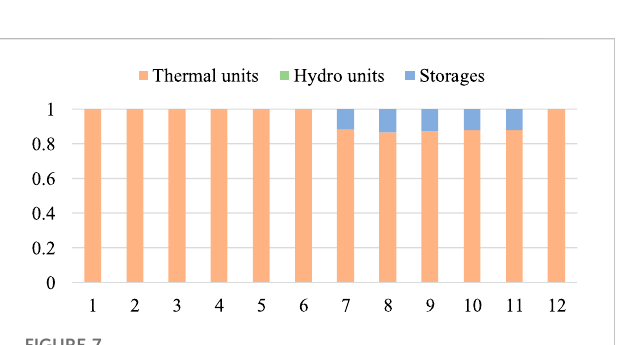
FIGURE 7 Af fi ne factors for the downward source-load